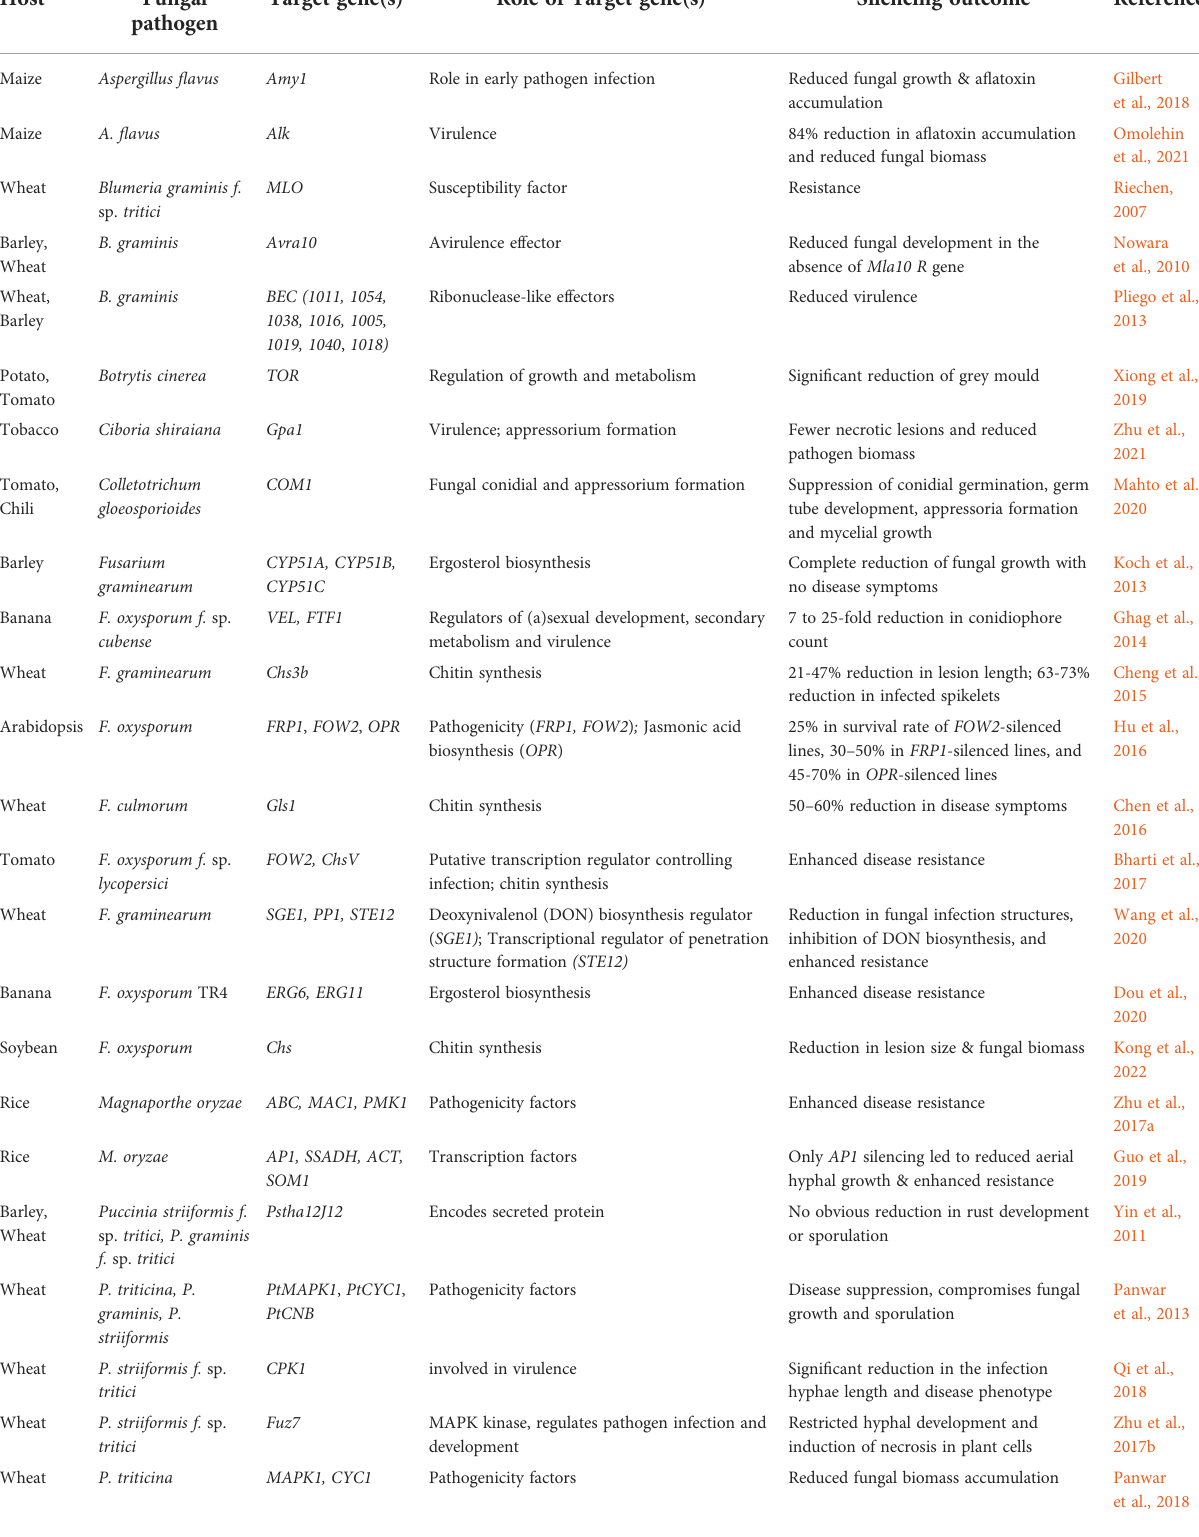
TABLE 1 List of phytopathogenic fungal genes targeted through Host-Induced Gene Silencing